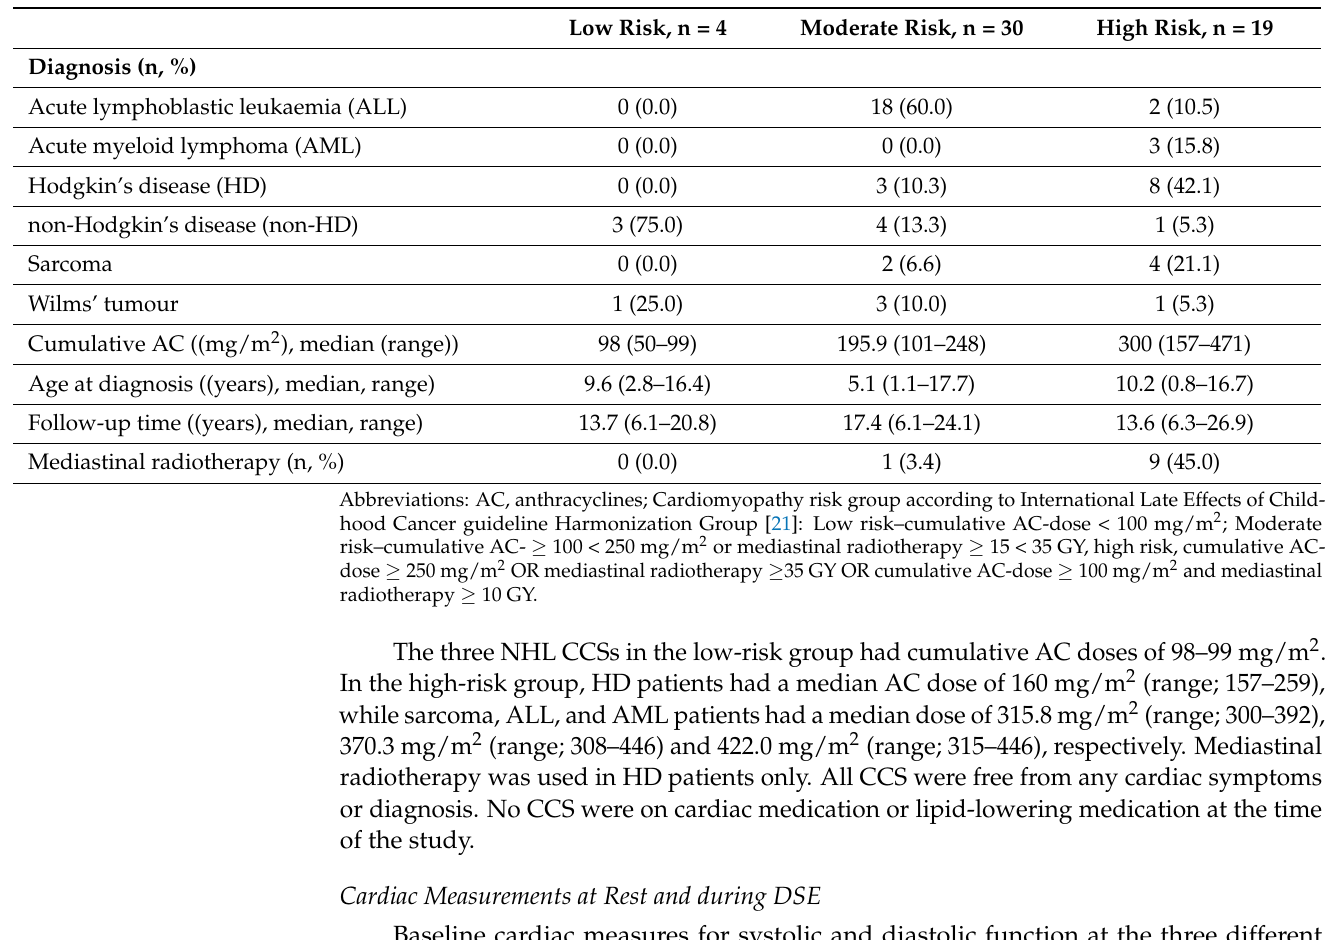
Table 2. CCS Characteristics according to Cardiomyopathy Risk Group. Adapted with permission from [21], copyright 2023, OB.